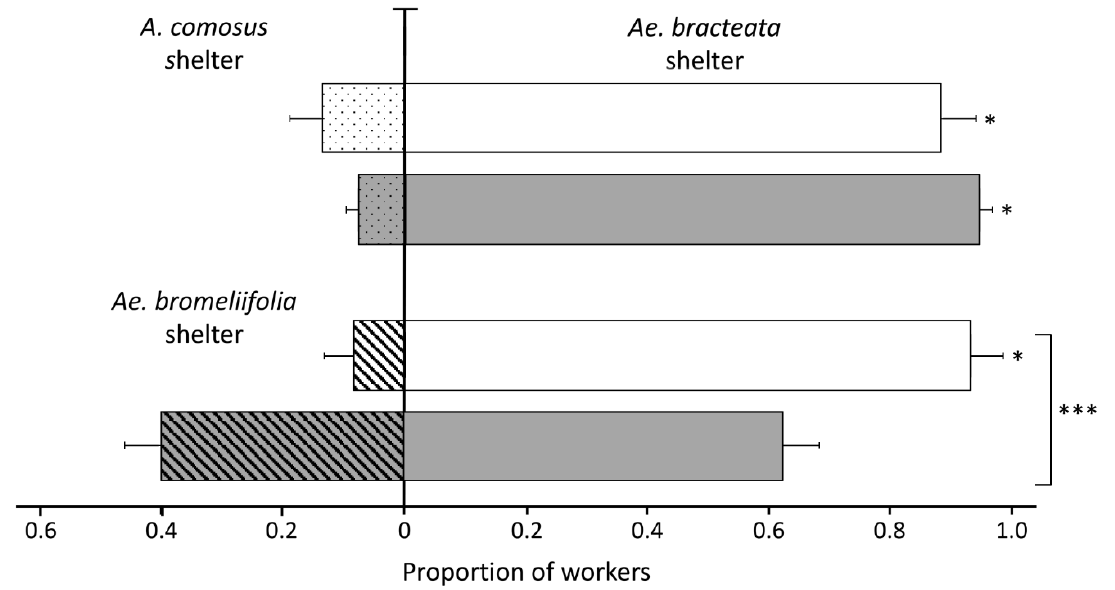
Figure 2. Mean proportion of N. villosa workers ( ± SEM) in shelters consisting of leaves of Aechmea bracteata (empty bars) vs. leaves of two other bromeliads, Ae. bromeliifolia (stripped bars) or Ananas comosus (dotted bars). Workers from colonies of two distinct origins were tested, i.e., workers originally nesting in Ae. bracteata (n = 30 trials, grey bars) and workers from colonies previously nesting in tree cavities (n = 21 or n = 26 trials, white bars). * p < 0.05, *** p < 0.0001, GLMM Wald χ 2 .